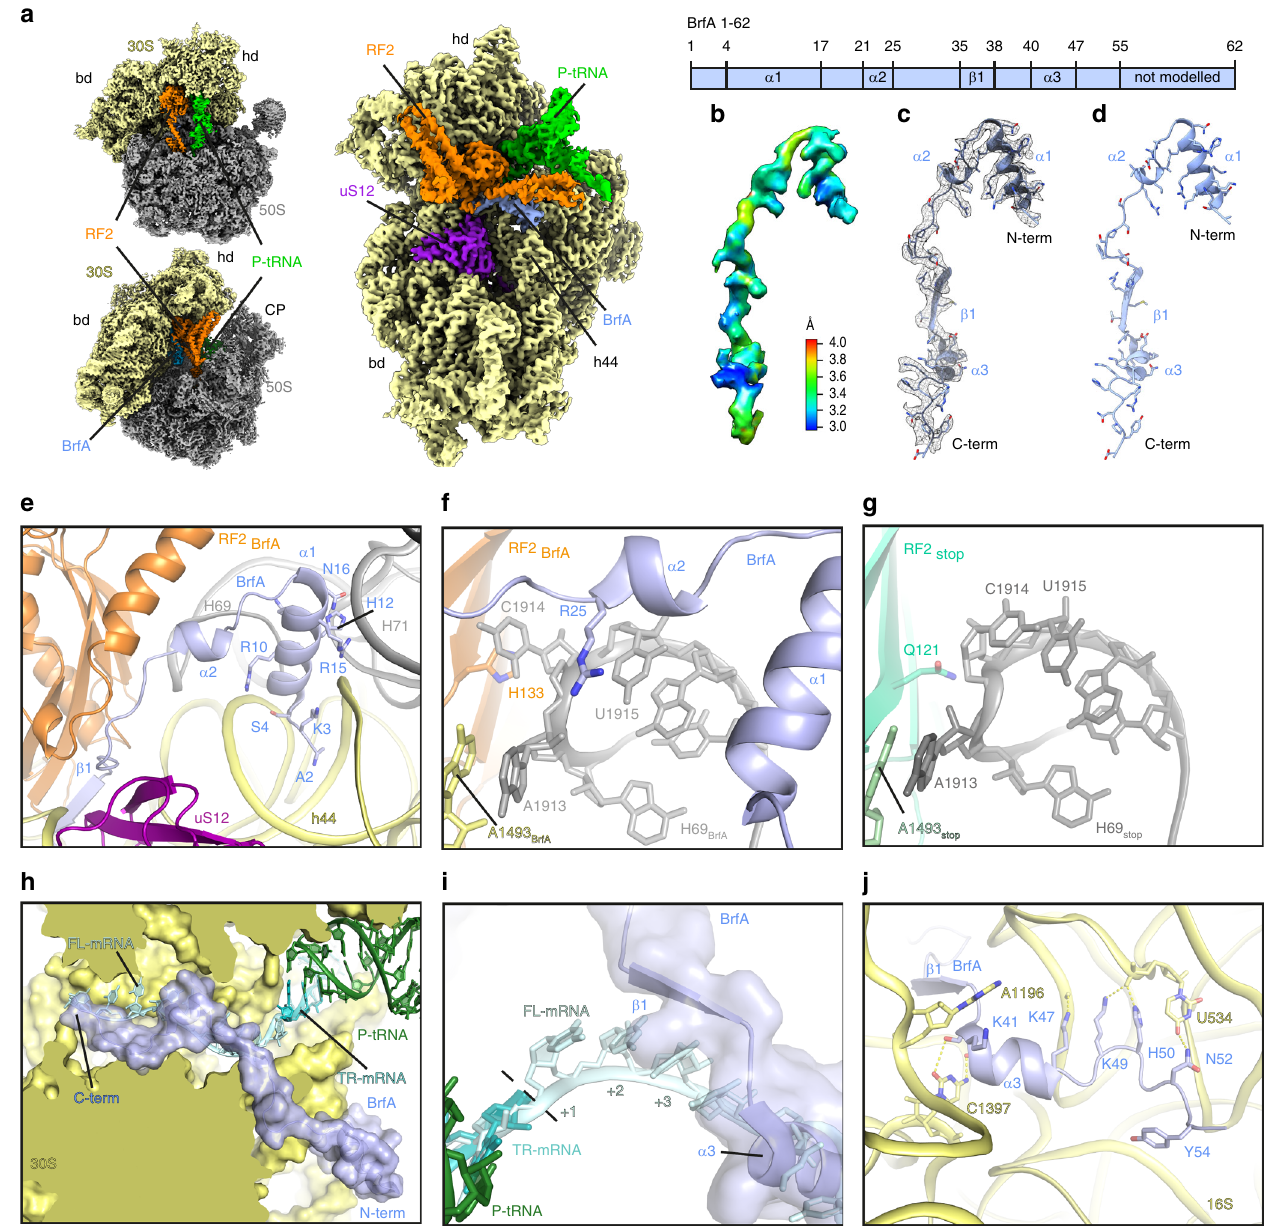
Fig. 4 Cryo-EM structure of BrfA-RF2-ns70S complex. a Different views of the cryo-EM map of the BrfA-RF2-ns70S complex with isolated densities highlighting the 30S (yellow: hd, head; bd, body) and 50S (gray: CP, central protuberance) subunits, P-site tRNA (green), RF2 (orange), and BrfA (blue). b , c Isolated electron density for BrfA ( b ) colored according to local resolution and ( c ) shown as mesh (gray) with fi tted molecular model for BrfA. d Model for BrfA with features highlighted corresponding to the schematic of BrfA protein, including α -helical and β -strand regions. e The N-terminus of BrfA (blue) interacts both h44 of the 16S rRNA (yellow) and H69 and H71 of the 23S rRNA (gray). f The conserved R25 of BrfA (blue) stacks upon U1915 and causes C1914 to fl ip out and stack upon H133 of RF2. g Same view as f but showing the RF2 stop (lime) and the conformation of H69 for a canonical termination complex (PDB ID 4V5E 48 ). h Transverse section of the 30S subunit (yellow) to reveal the mRNA channel showing a superimposition of full-length mRNA (FL-mRNA, cyan) with truncated non-stop mRNA (TR-mRNA, teal), P-site tRNA (green), and surface representations of BrfA (blue). i Superimposition of FL-mRNA (cyan) with TR-mRNA (teal), P-site tRNA (green), and transparent surface representation of BrfA (blue). The fi rst ( + 1), second ( + 2), and third ( + 3) nucleotides of the A-site codon of the FL-mRNA are indicated. j Interaction of the C-terminus of BrfA (blue) with the 16S rRNA showing potential hydrogen bonds with yellow dashed